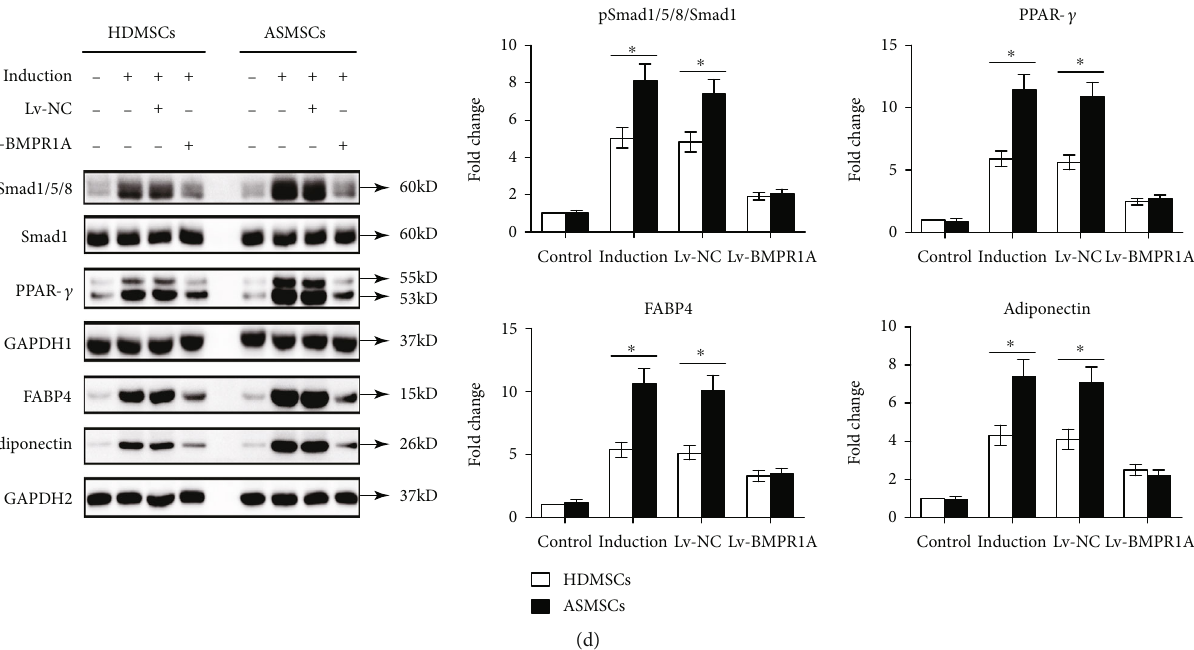
Figure 5: Lentiviruses encoding shRNA-BMPR1A had a greater inhibitory e ff ect on adipogenic di ff erentiation in ASMSCs than in HDMSCs. (a) The transfection and knockdown e ffi ciencies were comparable between HDMSCs ( n = 30 ) and ASMSCs ( n = 25 ). (b) After transfection, ORO staining and ORO absorbance were decreased in both HDMSCs ( n = 30 ) and ASMSCs ( n = 25 ). However, Lv-BMPR1A exerted a stronger inhibitory e ff ect on ASMSCs than on HDMSCs, leading to a comparable OD value between HDMSCs and ASMSCs. (c) Lv-BMPR1A inhibited expression of the PPAR- γ , FABP4, and adiponectin mRNAs in both HDMSCs ( n = 30 ) and ASMSCs ( n = 25 ). Lv-BMPR1A exerted a greater inhibitory e ff ect on ASMSCs than on HDMSCs. (d) Levels of the pSmad1/5/8, PPAR- γ , FABP4, and adiponectin proteins in HDMSCs ( n = 30 ) and ASMSCs ( n = 25 ) were consistent with their gene expression levels. Values are presented as the means ± SDs . ∗ P < 0 : 05 for the di ff erences between HDMSCs and